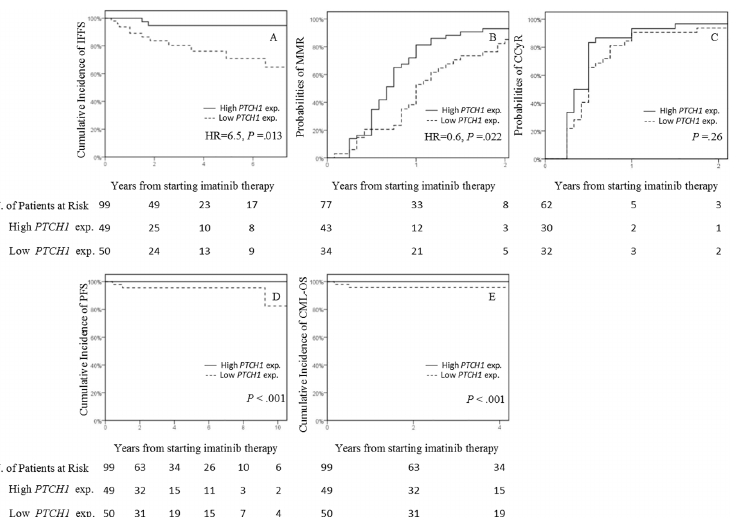
Fig 3. Cumulative incidence or Kaplan-Meier analysis of four different outcomes in the high and low PTCH1 expression groups. HR, hazard ratio; exp, expression; IFFS, imatinibfailure-freesurvival; MMR, major molecularresponse; CCyR, completecytogenetic response; PFS, progression-free survival; CML-OS, CML-related overall survival; N, number. The solid line indicateshigh PTCH1 expression ( > 0.0259)and the dashedline low PTCH1 expression. Non-CML-related death was considereda competingrisk in every variableanalyzedby the cumulativeincidenceprocedure.In addition,discontinuation of imatinibdue to side effects was considered a competingrisk for the analysisof IFFS. The HR is not shown if no event was recordedin any of the groups due to non-preciseestimations. (A) IFFS analyzedby the cumulative incidence procedure and the Fine-Gray test. (B) MMR analyzedby Kaplan-Meier plot, log-ranktest, and Cox regression (for HR estimation). (C) CCyR analyzedby Kaplan-Meier plot and log-ranktest. (D) PFS analyzedby the cumulative incidenceprocedure and the Fine-Gray test. (E) CML-OS analyzedby the cumulative incidence procedure and the Fine-Gray test. https://doi.org/10.1371/journal.pone.0181366.g003 EUTOS and Sokal scores were included in the final model ( P = 0.008, HR = 7.7, 95% CI 1.7– 33.3; P = 0.007, HR = 4, 95% CI 1.5–10.8; and P = 0.021, HR = 3.9, 95% CI 1.2–12.5, respec- tively). The P- value and HR shown for Sokal score were obtained from the comparison of low and high risk groups. No significant difference was found between the intermediate and low